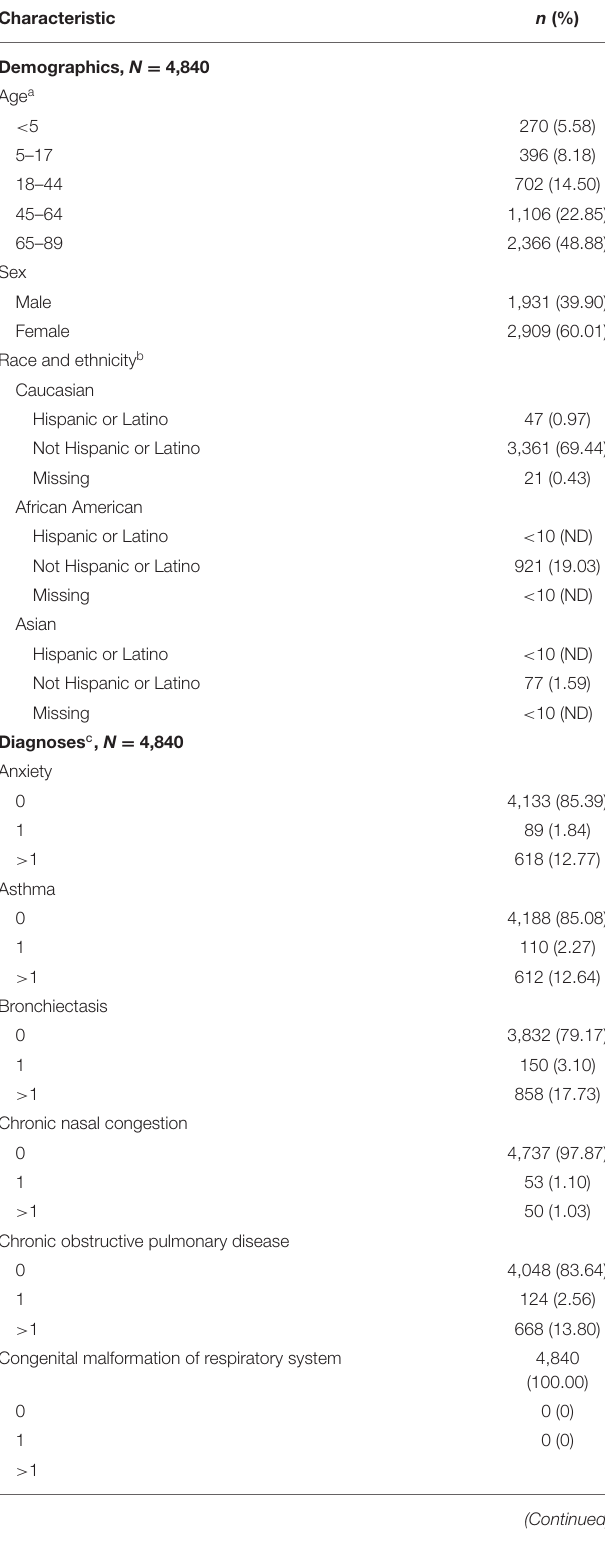
TABLE 1 | Demographics, co-diagnoses, and environmental exposures among patients within the ICEES rare pulmonary disease cohort ( N = 4,840).